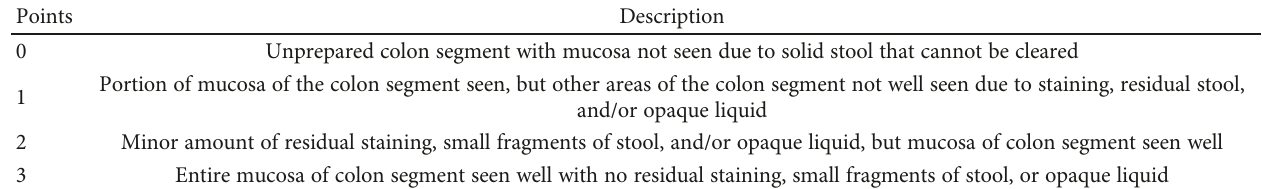
Figure 1: The fl ow chart of the study. Table 1: The Boston Bowel Preparation